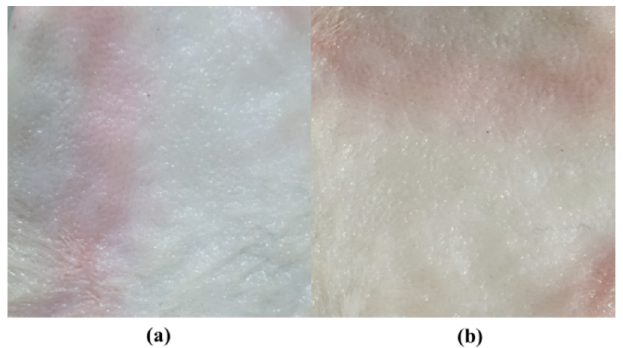
Figure 9. Irritation testing after application of dMNP, ( a ) Microneedle patch loaded with Simvastatin on skin before application at 0 h, ( b ) After 48 h of application.